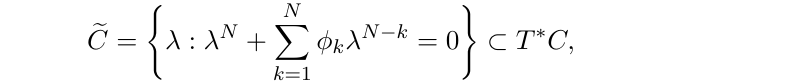
Figure 7 . An ij -leaf with its two